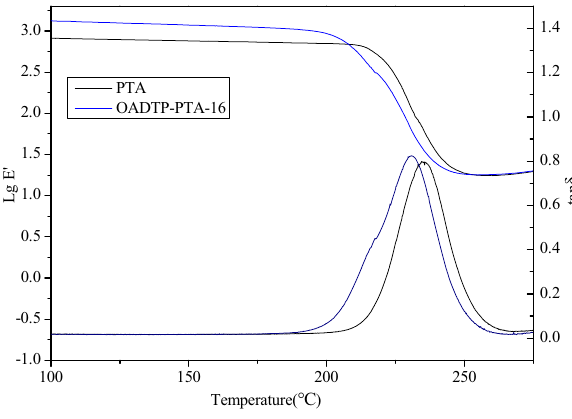
Figure 8: DMA curves of cured PTA and OADTP - PTA - 16 resin.